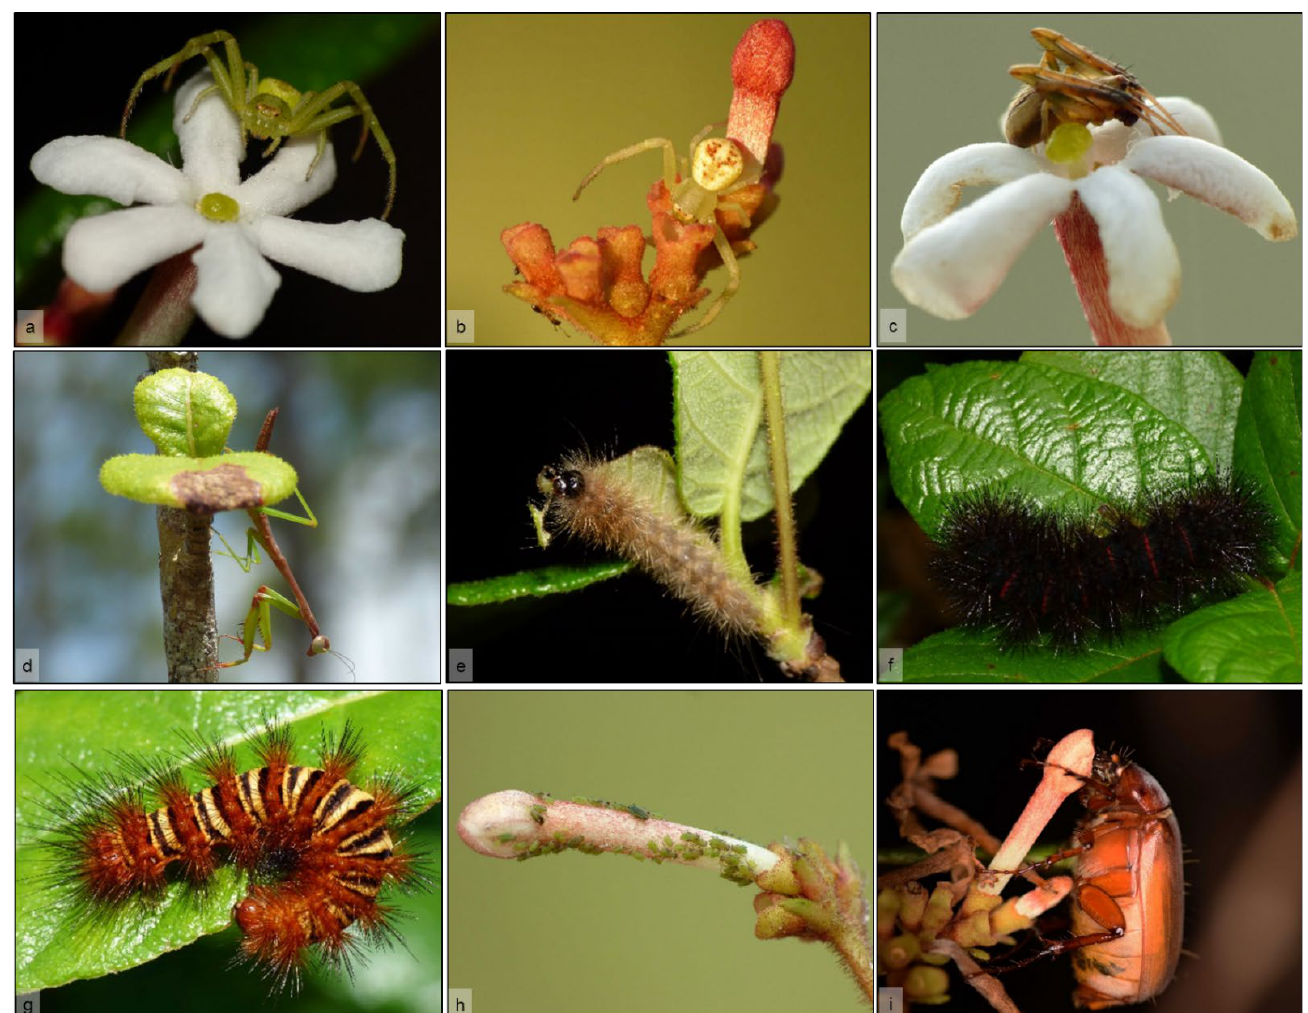
Figure 6. Overview of predatory and herbivorous arthropods on Guettarda scabra in pine rockland habitats in south Florida, USA. ( a ) Crab spiders of the genus Mecaphesa in hunting position on a corolla, and ( b ) on an unopened bud. ( c ) Orbweaver spider Acacesia hamata sitting on an open flower almost touching the exposed stigma. ( d ) Praying mantis Stagmomantis floridensis exploring a branch in the morning. Caterpillars of the erebid moths ( e ) Calidota laqueata , ( f ) Hypercompe scribonia , and ( g ) Seirarctia echo , found consuming leaves of G. scabra . Other herbivores found associated with flowers include ( h ) clusters of aphids sucking sap from a flower bud, and a ( i ) May beetle Phyllophaga sp. chewing on a flower bud at night.